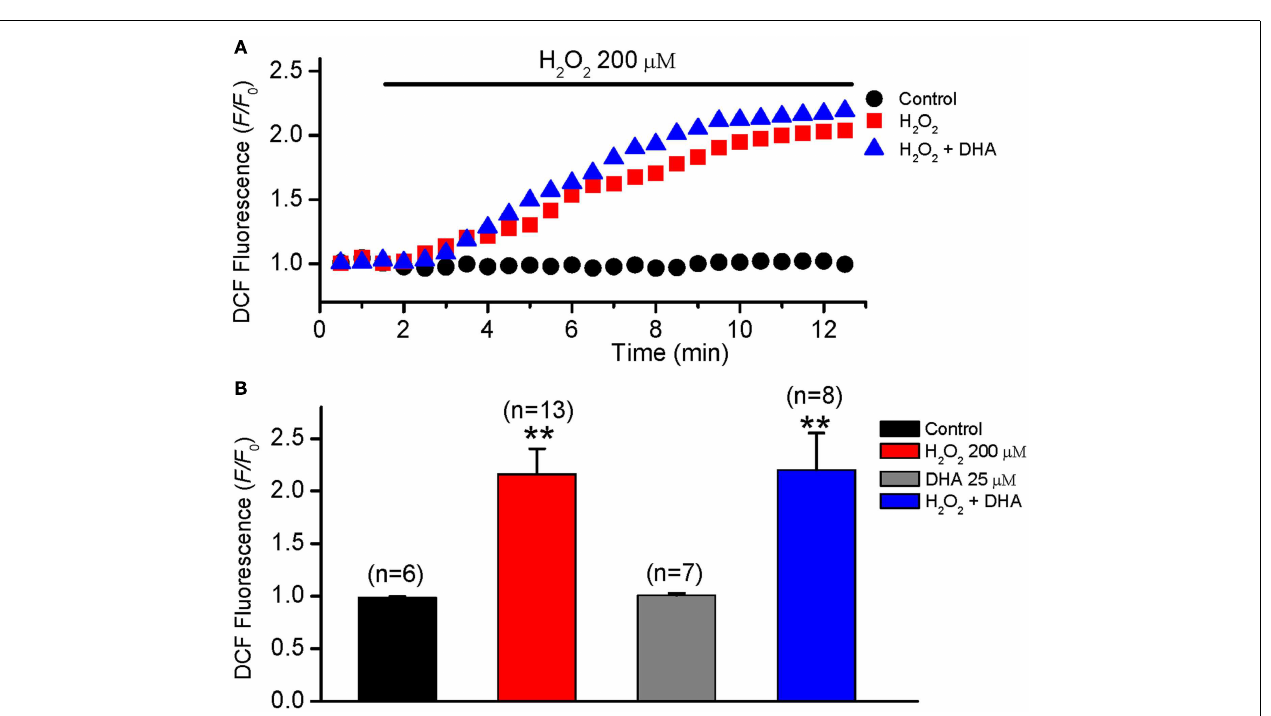
FIGURE 4 | Less effect of DHA on I to enhanced by H 2 O 2 . (A) Time course of peak I to in a myocyte treated with H 2 O 2 in the absence and presence of DHA. (B) Representative traces of the I to under control, in the presence of H 2 O 2 (200 µ M), and H 2 O 2 + DHA (25 µ M), respectively. (C) Current–voltage relations of the peak I to (C-a) and steady state currents